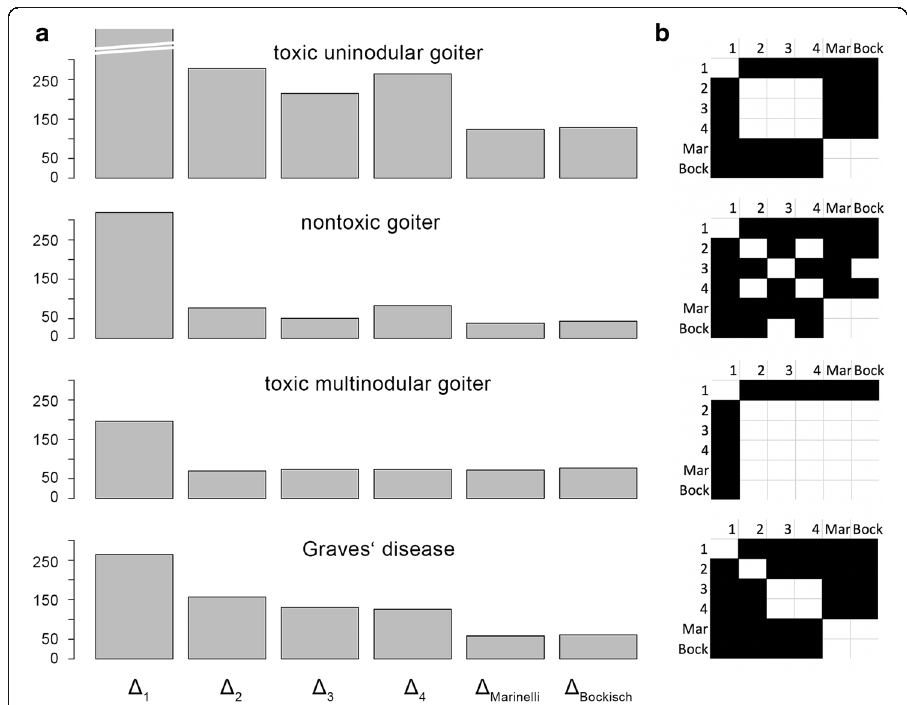
Fig. 1 Disease entity-wise root mean squared deviations Δ i of hypothetically achieved doses. a Root mean squared deviations Δ i of hypothetically achieved doses ( D ha ) in Gy from target doses ( D t ) for approaches 1 – 4 and activities derived from EANM SOP 8 (Marinelli) and 9 (Bockisch) for each disease entity. b Results of pair-wise t tests between root mean squared deviation comparing all approaches. Black cells indicate significant differences between compared groups (i.e., p